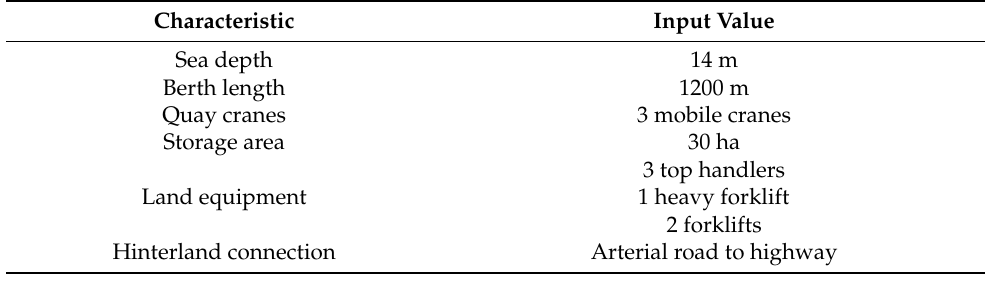
Table 1. Port of Augusta container terminal characteristics.